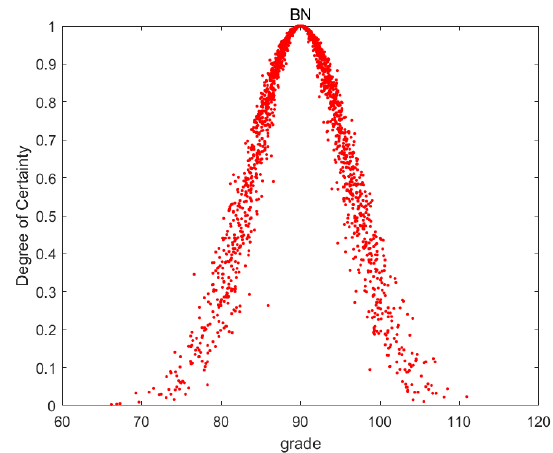
Figure 9. Cloud image of BN. The degree of dispersion of the droplets in Figures 3–9 indicates the inconsistency of individual scores for this indicator. It can be seen from the figures that the degree of dispersion of RN, LG, TC, and BN is significantly smaller, indicating that the score trends for these indicators are consistent. The middle line of the images in the figures represents the mean value of the indicators. The mean value of the indicators is adjusted according to the degree of dispersion. The higher the degree of dispersion, the greater the divergence of individual scores on this indicator, which should be reduced on the basis of the mean value. The mean value ( Ex ), entropy ( En ), and hyper-entropy ( He ) of the eight factors are shown in Table 5: Table 5. The descriptive statistics of cloud models.